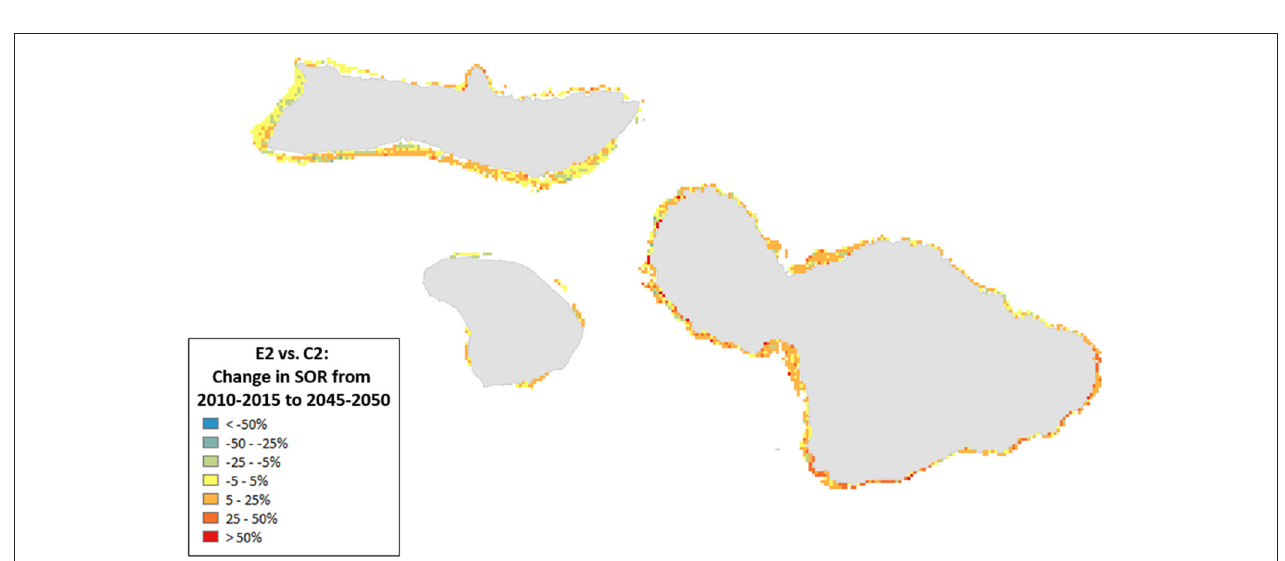
FIGURE 9 | Ratio of the change in State of the Reef (2010–2050) for scenario E2 (high sediment mitigation, 30% MPAs) compared to C2 (Current Management) under less severe climate-related stressors. A value of 0 indicates no change from the outcome in 2050 under Current Management, values > 0 indicate an improvement (or, more accurately, less of a decline from the Current Management), while values < 0 indicate a worsening of the decline relative to Current